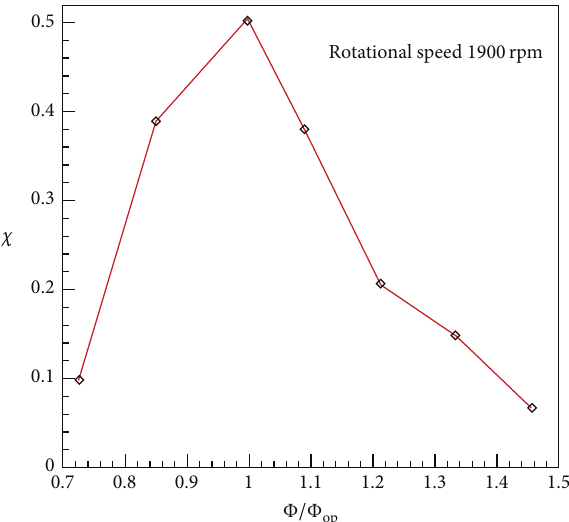
Figure 14: Static pressure recovery in the draft tube.